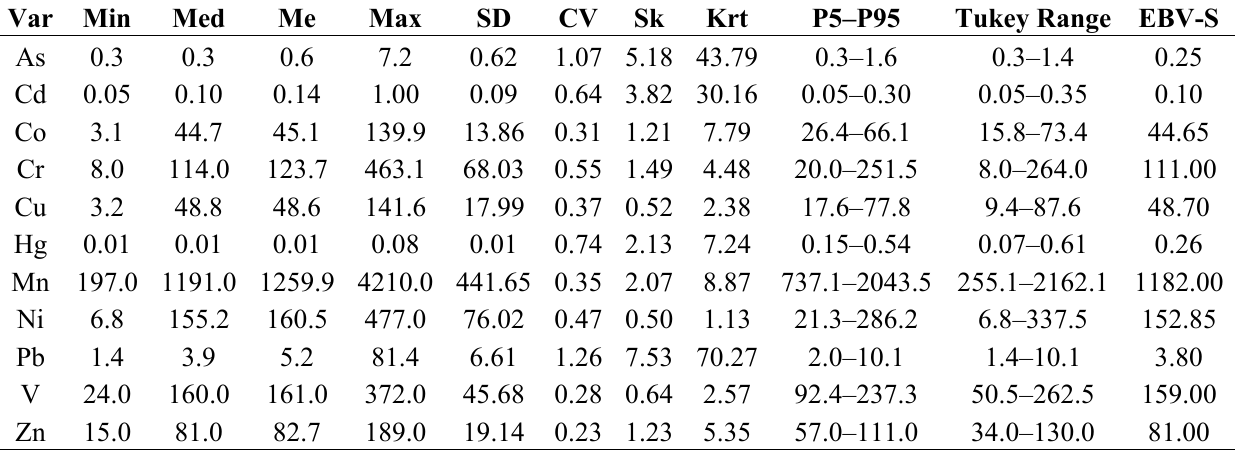
Table 2. Statistical As, Cd, Co, Cr, Cu, Hg, Mn, Ni, Pb, V, and Zn variables analysed, interval ranges, and the baseline values (EBV-S) of metals from the stream sediments of Santiago Island ( n = 337). Values expressed in mg·kg − 1 .